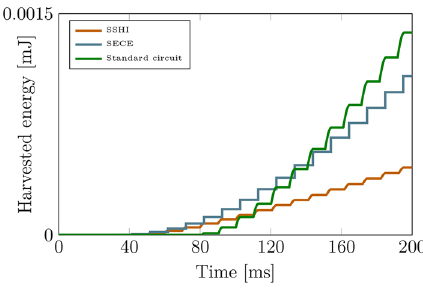
Fig. 9 Harvested energy E of the bimorph PVEH with standard, SSHI and SECE circuit under a harmonic base acceleration of 0.5 m/ s 2 and a frequency of 48.7 Hz